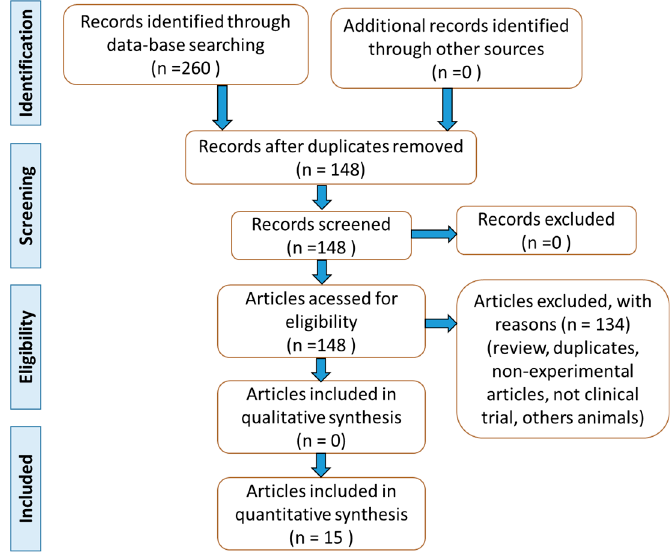
Figure 4. Flow diagram showing the results of the search according to PRISMA guidelines [48].